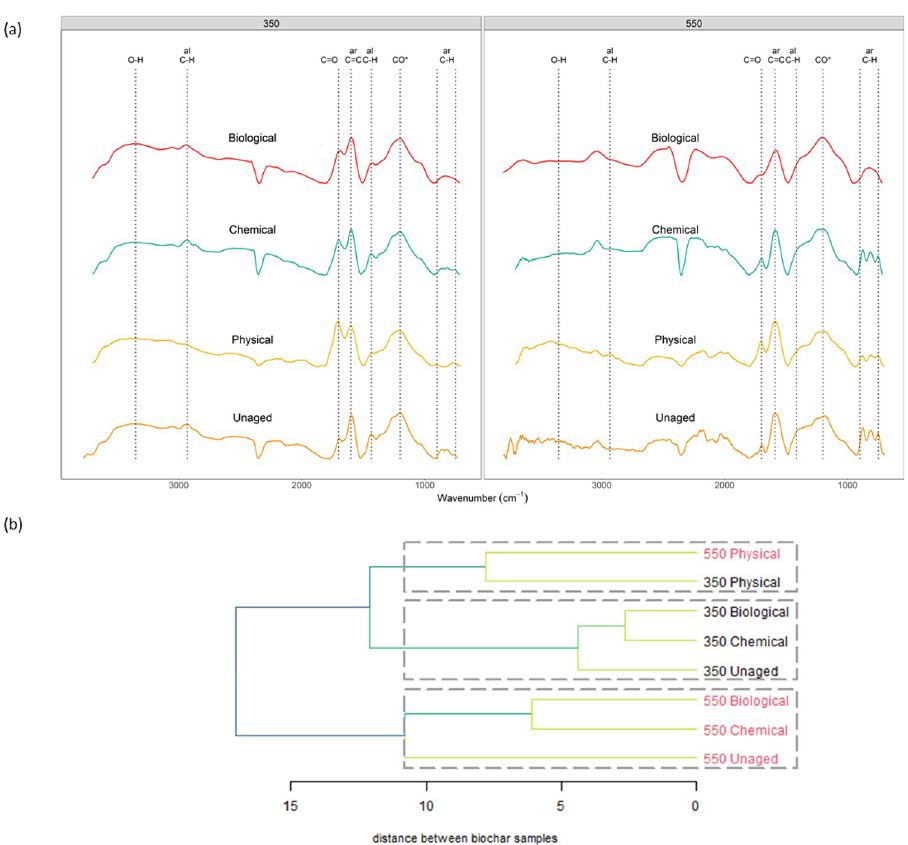
Fig 2. Changes in surface chemistry during ageing inferred using FTIR spectroscopy (a) FT-IR spectra of unaged and physically, chemically and biologically aged biochar samples produced at 350˚C (left panel) and 550˚C (right panel). Labels on top indicate the peak names assigned to different functional groups as described in detail in supplementary information (O-H: O–H stretching in carboxylic acids, phenols, alcohols at 3370 cm -1 ; al CH: aliphatic C-H stretch in CH 3 and CH 2 at ~2932 cm -1 and C-H bending of CH 3 and CH 2 at 1413 cm -1 ; CO 2 : CO 2 asymmetric stretching at 2350 cm -1 ; C = O: C = O stretch in carboxylic acids and ketones at ~1701 cm -1 ; ar C = C: aromatic C = C vibrations and stretching of quinones at ~1593 cm -1 ; CO � : C–O stretching and O–H bending of COOH and/or C–OH stretching of polysaccharides at ~1200 cm -1 ; ar C-H: aromatic C-H out of plane deformation at 810 cm -1 . (b) The clustering of biochar FT-IR spectra based on Ward’s hierarchical clustering method represented as a dendrogram. The distance of the link between any two clusters (or samples) is a measure of the relative dissimilarity between them. 1413 cm -1 aliphatic C-H stretch after ageing but the same was not observed in the case of the C = C aromatic stretch. These changes indicate a relative loss or transformation of both surface aliphatic and aromatic carbon groups during ageing. As discussed earlier, the loss in C could be due to leaching or abiotic oxidation of C during ageing. Further, in the case of biological ageing, the relative loss in aliphatic C group at 1413 cm -1 and 2932 cm -1 (for 350˚C chars) could be a result of decomposition of aliphatic C by soil microbes [25, 26, 57]. While it may not be possible to conclusively determine whether oxidized functional groups were previously associated with aromatic vs. aliphatic compounds, the drop in relative heights in the aromatic regions (810 and 1593 cm -1 wavenumbers) accompanied by a relative increase in signal for car- boxyl (1701 cm -1 ) group suggests that the oxidation of aromatic C results in the development of carboxylic groups. It has been previously suggested that oxidation on the edges of the aro- matic backbone of biochar, taking place over a long period of time, could lead to the formation of negatively charged carboxyl groups [56, 58, 59]. A loss in aromatic functional groups was